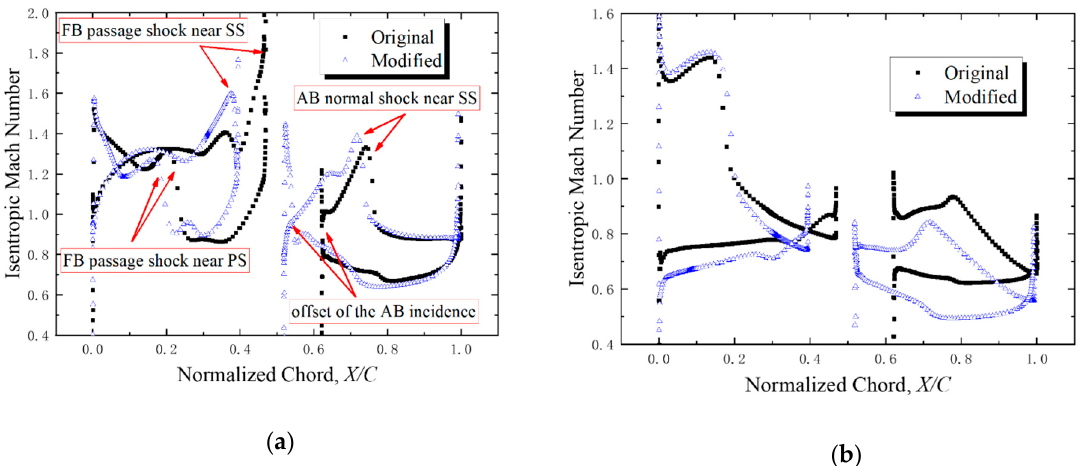
Figure 12. The optimal blade Mach contour plots in typical working conditions. ( a ) At the DE point, ( b ) At the NS point.